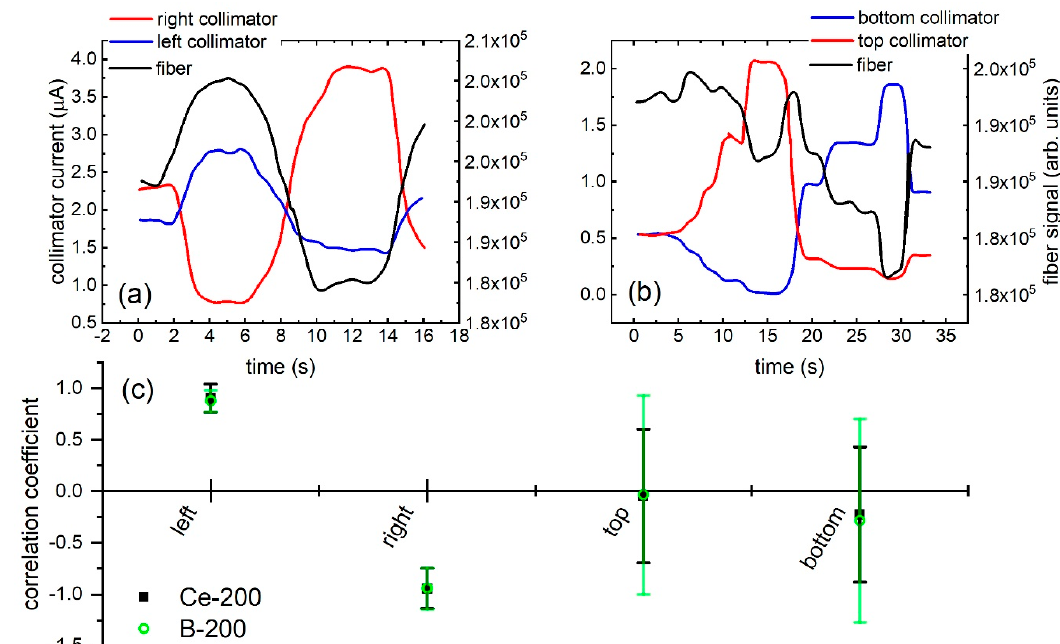
Figure 4. In ( a ) and ( b ), the collimator currents are compared with the Ce-200 fiber’s signal while at a beam current on the target of 20 µA. Both fibers are mounted at the side of the target closest to the bottom collimator. The bar graph in ( c ) expresses the correlations between the collimator currents and the fiber signal when the target selector was moved in the plane that the collimators were positioned in, and the beam current’s correlation during these periods.